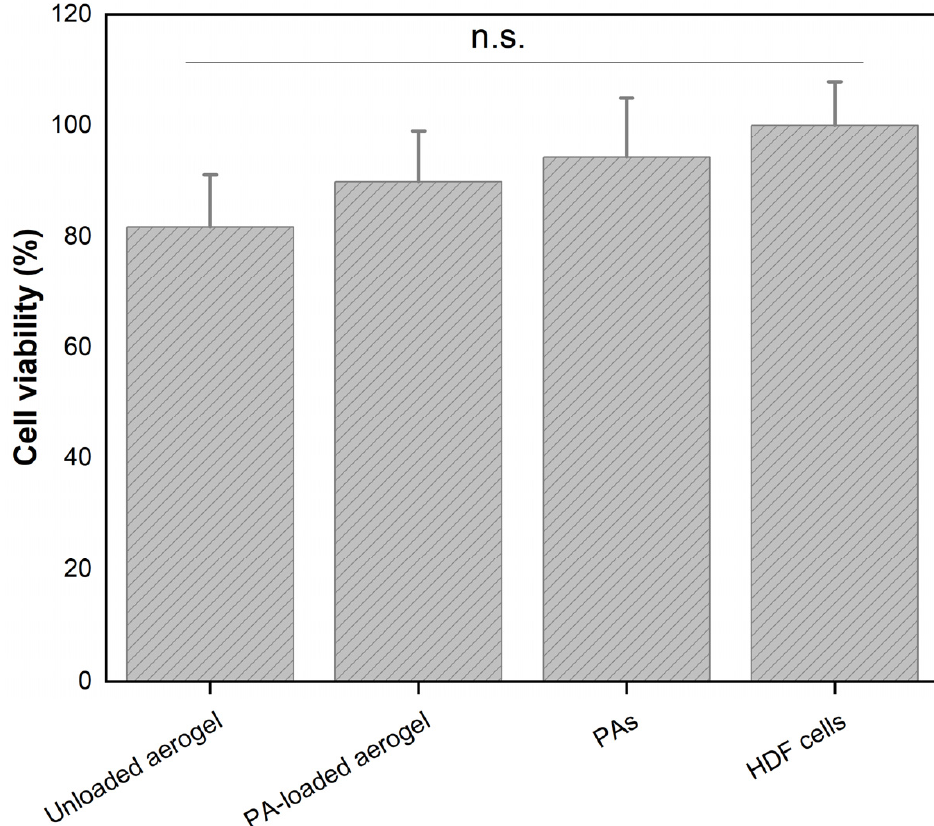
Figure 3. In vitro cell viability values for PAs and aerogels evaluated on HDF cells. Data correspond to mean ± SD value ( n = 6, n.s.: non-significant statistical differences, p -value < 0.05).